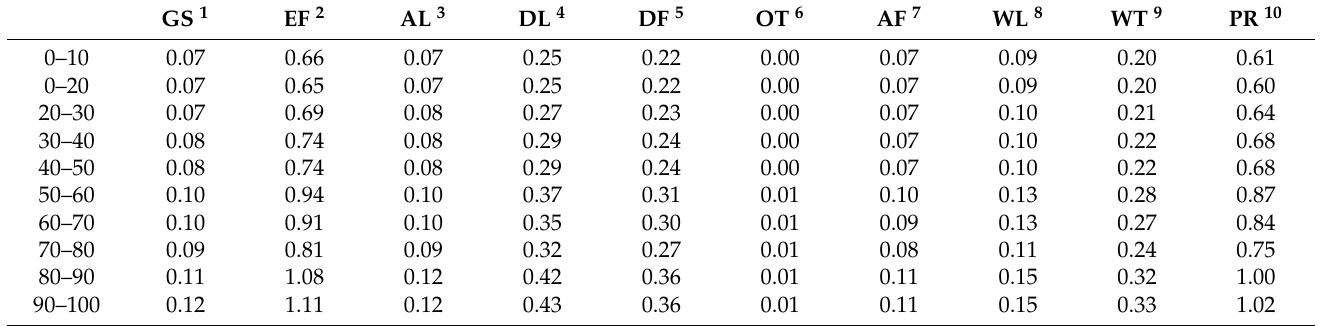
Table A3. Class and area group-wise classification accuracy for MODIS imagery in the Mun River